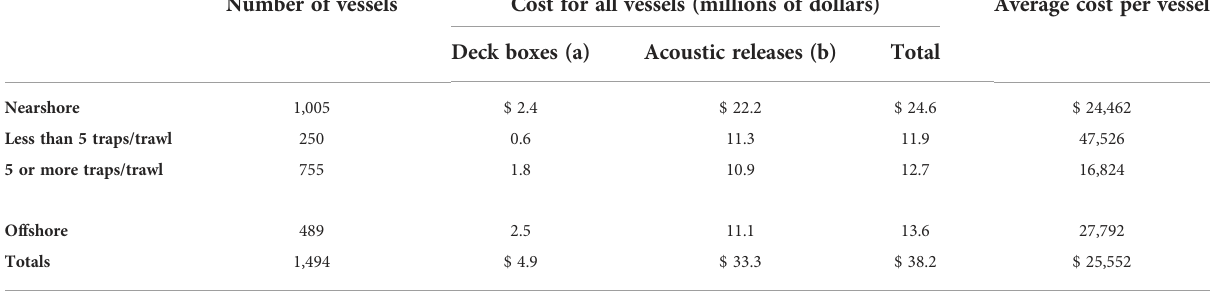
TABLE 6 Total on-demand fi shing gear adoption costs for 1,494 vessels, releases on 1 of 2 endlines per trawl for vessels fi shing more than 5 traps per